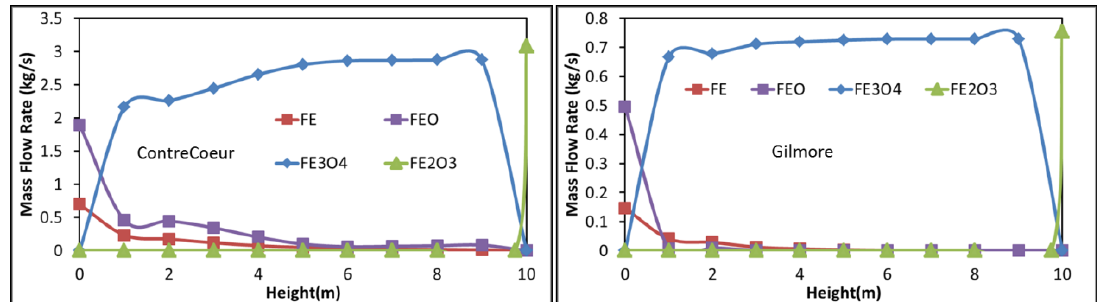
Figure 7. Evolution of the solid component flow rates with shaft height in Zone 2, ( a ) Contrecoeur; ( b ) Gilmore.